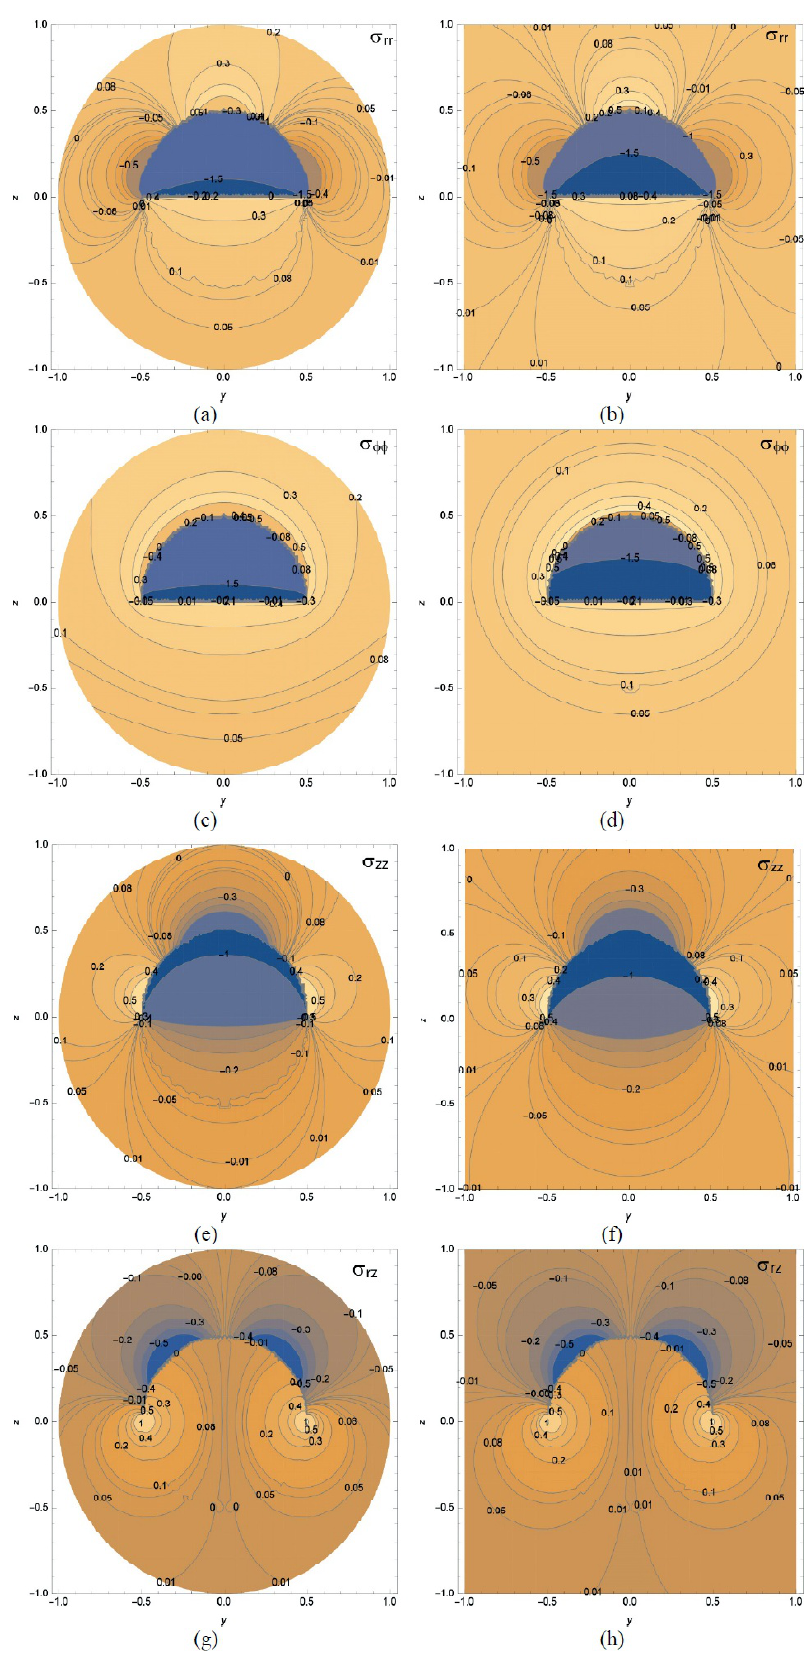
Fig. 3. Maps of stresses caused by a hemispherical dilatation inclusion in an elastic sphere (a, c, e, g) and an infinite elastic medium (b, d, f, h). The stress values are given in units of G  *(1+  )/(1-  ). The map coordinates are normalized to the sphere radius a . The calculations are made for the material with 